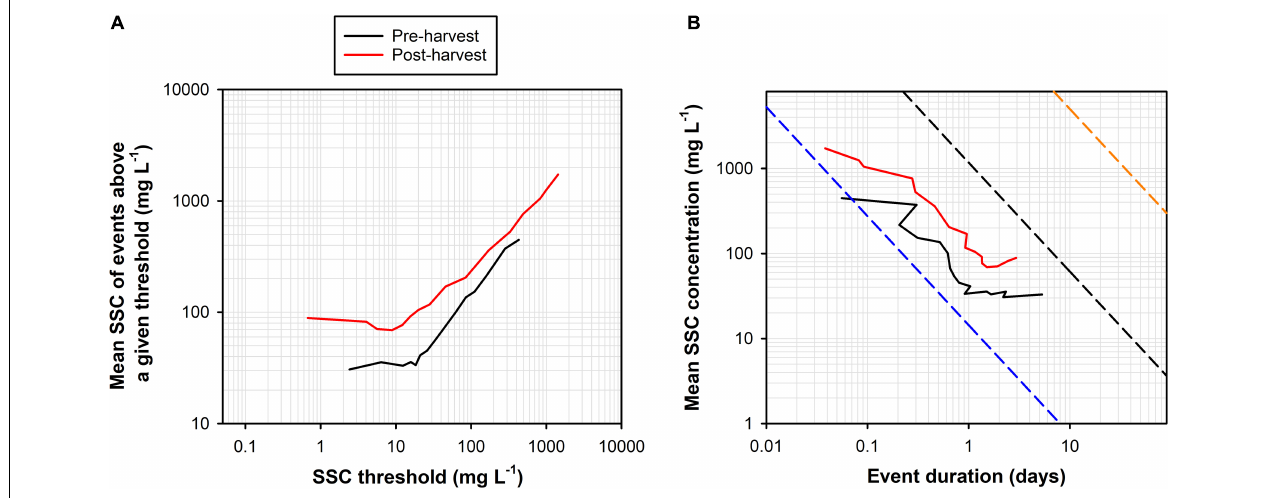
FIGURE 5 | Illustrative example of a magnitude-magnitude plot (A) and magnitude-duration plot (B) using pre- and post-harvest suspended sediment concentration (SSC) datasets from the Second Experiment in the North Fork. In (B) threshold levels from MODEL 3 included avoidance response (dotted blue line), moderated physiological stress (dotted black line), and reduced growth rate (dotted orange line).